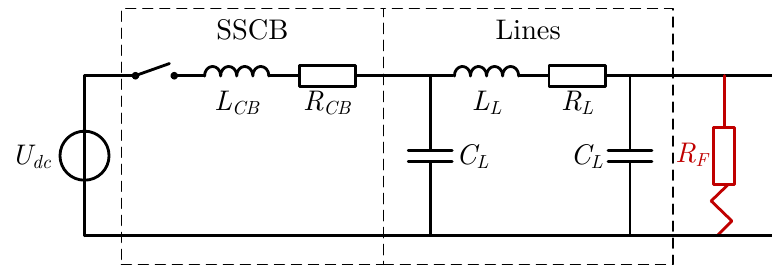
Figure 1. Equivalent circuit to calculate the worst-case short-circuit fault current in dc grids. Simulation results for the current during a low resistance fault (0.1 Ω ) and a high resistance fault (10 Ω ) are shown in Figure 2. The fault current is shown for different lengths of the distribution